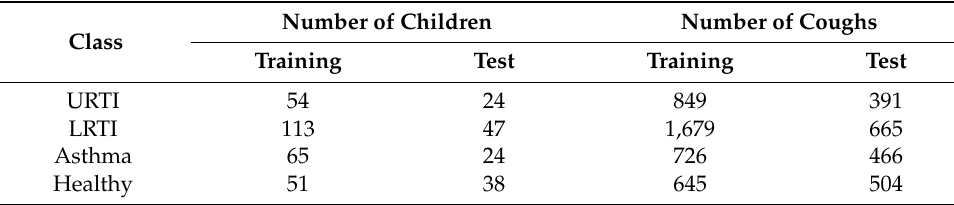
Table 2. Number of instances of the cough sounds in the training and test